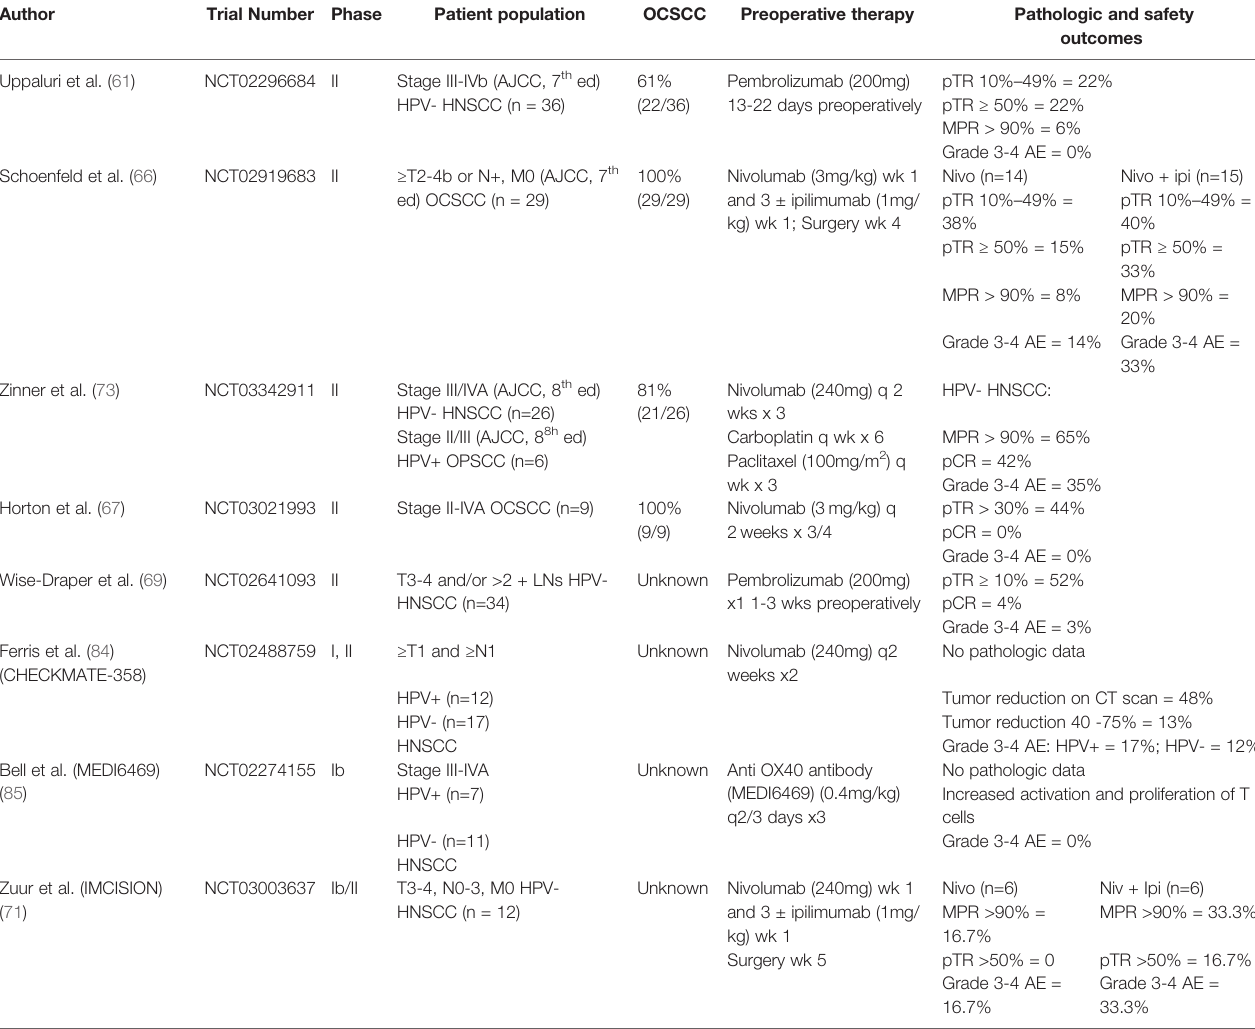
TABLE 3 | Results of published head and neck-speci fi c clinical trials using preoperative